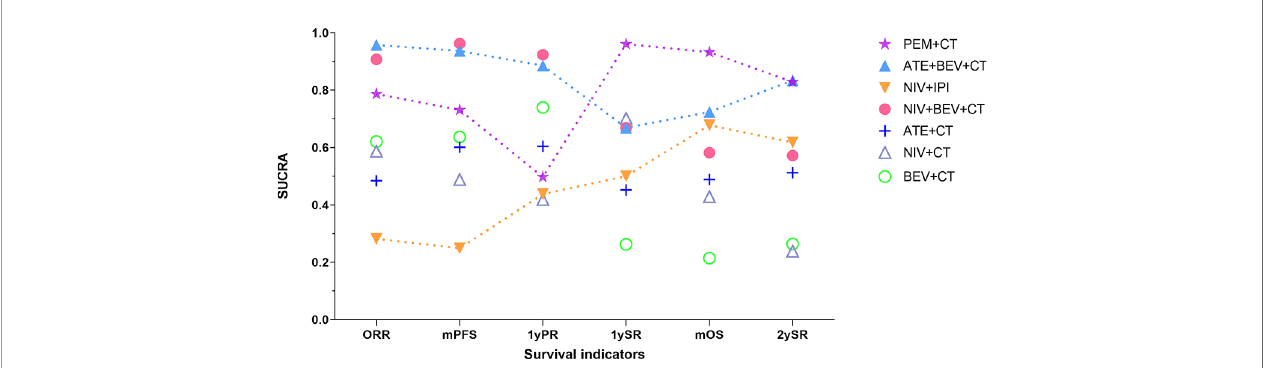
FIGURE 5 | Changing tendency in ef fi cacy ranking of main immuno-related therapies for advanced wild-type NSCLC as time goes on. The vertical axis represents the SUCRA value of ranking probability, and the horizontal axis represents survival indicators arranged in chronological order. PEM, pembrolizumab; ATE, atezolizumab; NIV, nivolumab; IPI, ipilimumab; BEV, bevacizumab; CT, chemotherapy; ORR, objective response rate; mPFS, median progression-free survival time; 1yPR, 1-year PFS rate, mOS, median overall survival time; 1ySR, 1-year survival rate; 2ySR, 2-year